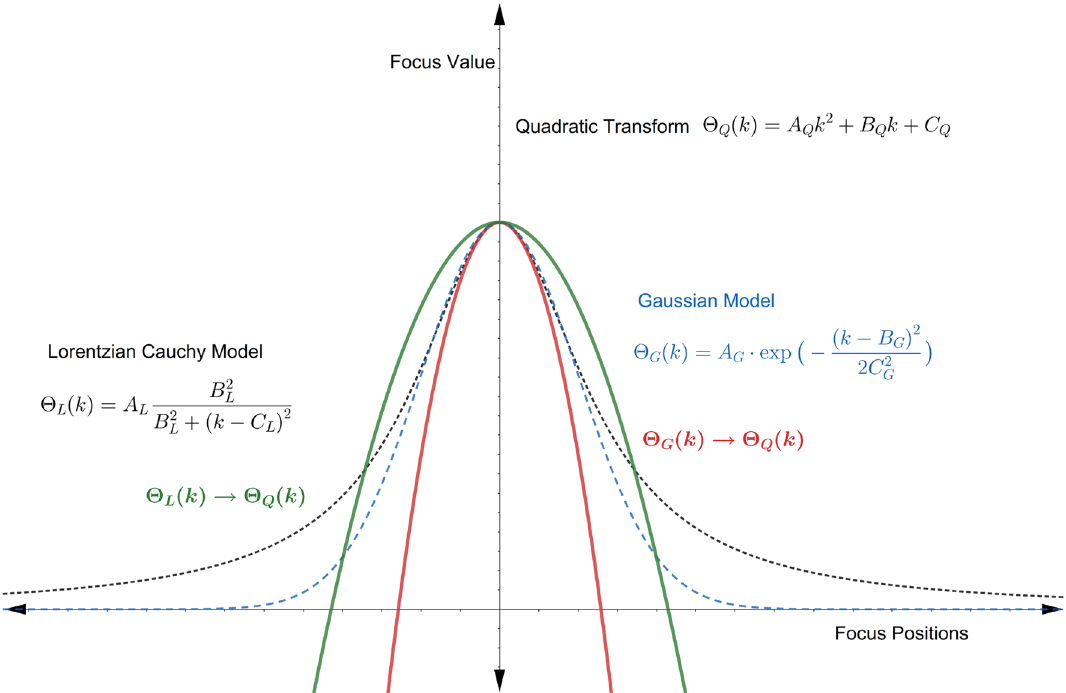
Figure 3. Transformation of Gaussian and Lorentz-Cauchy models into Quadratic